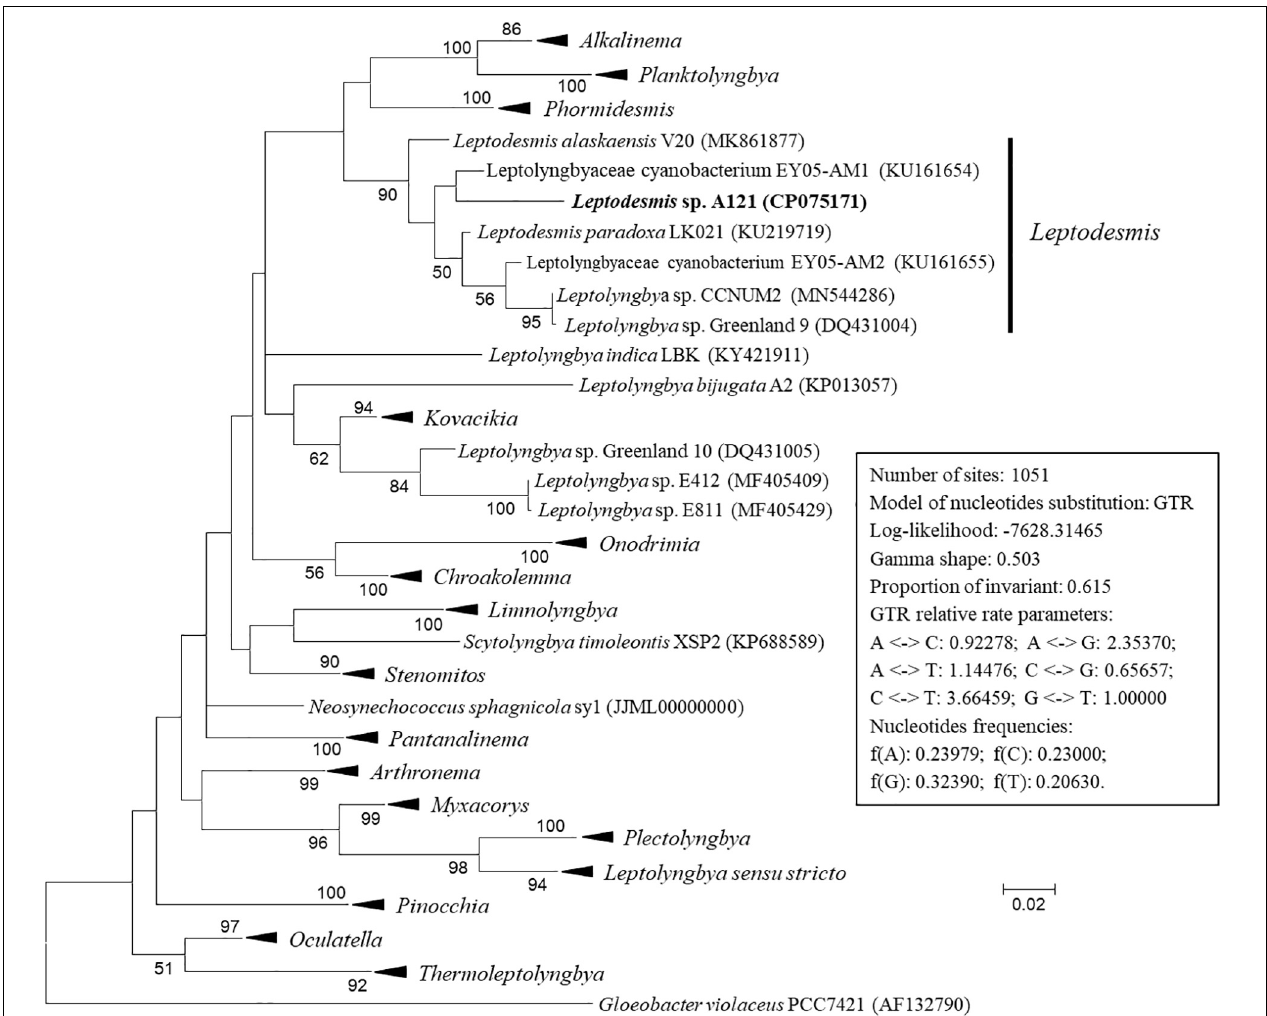
FIGURE 2 | Maximum-likelihood phylogenetic tree of 16S rRNA gene sequences. Branches of strains affiliated to the same genus were collapsed and referred by black triangle, followed by the genus name. The complete tree is shown in Supplementary Figure 1 . Only bootstrap values > 50% are indicated at nodes. Scale bar = 2% substitutions per